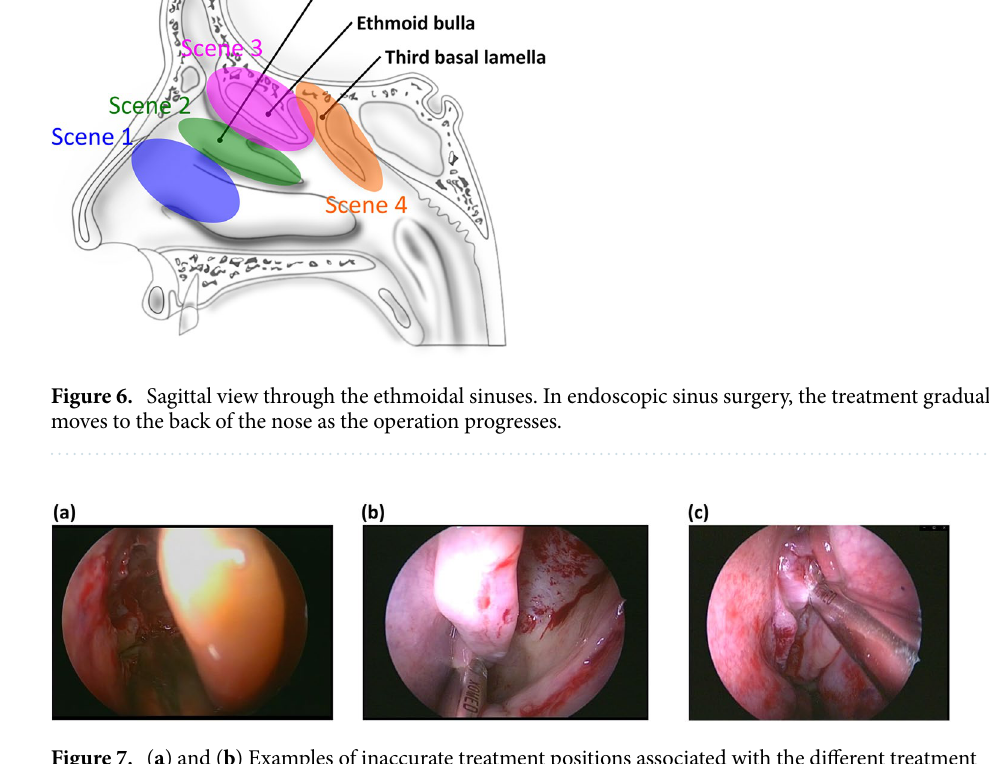
Figure 7. ( a ) and ( b ) Examples of inaccurate treatment positions associated with the different treatment position problem. ( c ) Standard position of an expert, when compared to the position in ( b ). In ( a ), the endoscope is more forward than its intrinsic position. In this situation, the surgical tool damages the middle turbinate. In ( b ), the endoscope is more downward than its intrinsic position, which is shown in ( c